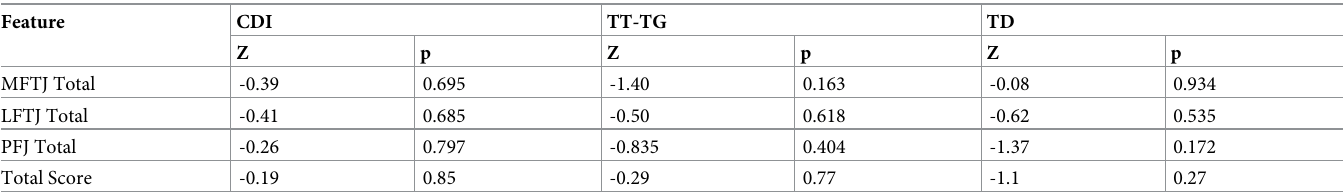
Table 4. Influence of anatomical risk factors for patella dislocation on knee joint damage.